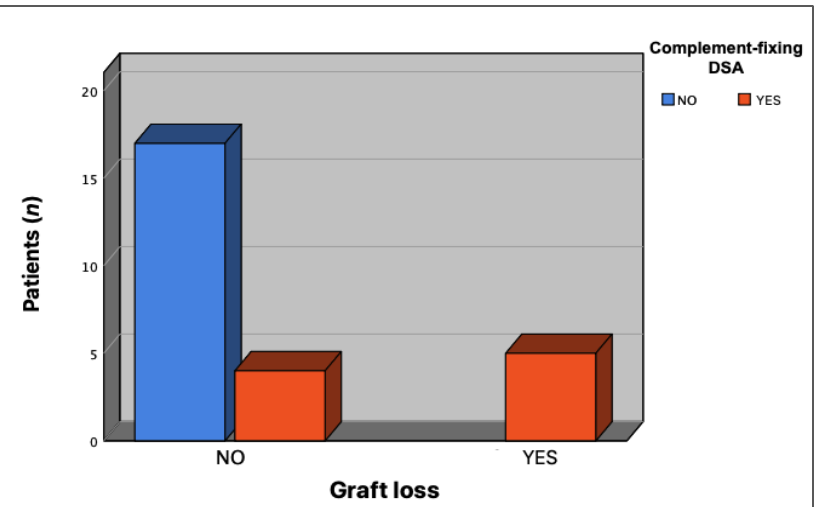
Figure 4. Association between the presence of complement-binding dnDSA and renal graft loss. Renal graft loss was observed in patients who developed C1q-binding DSA, with respect to those who did not ( p = 0.002).